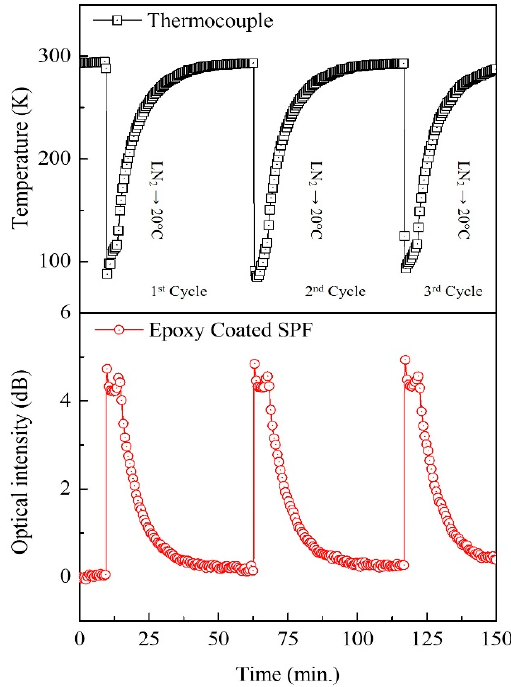
Figure 5. Repeatability test in multiple measurement cycles. Upper trace: thermocouple output; lower trace: output from the epoxy-coated SPF sensor.